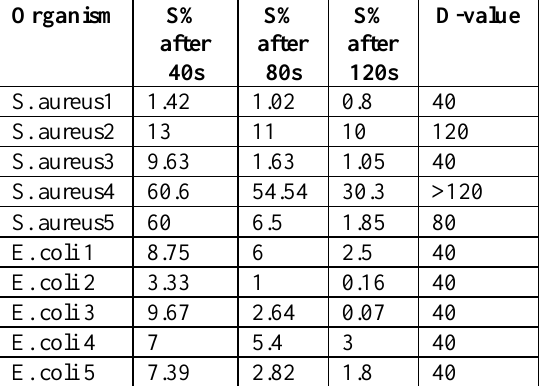
Table 3: Survival and D-value of ten different bacterial